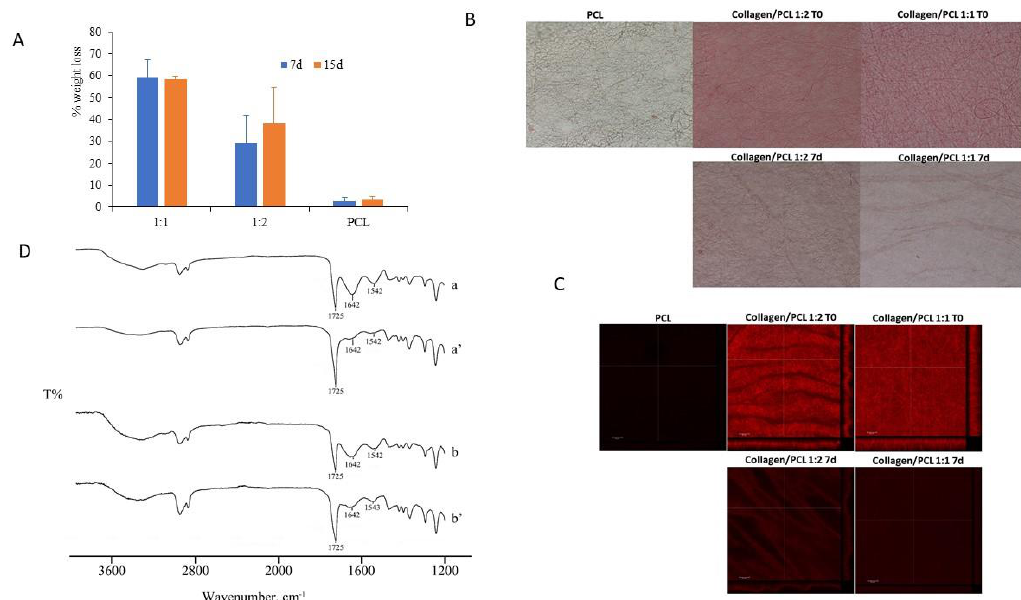
Figure 11. Collagen release from the nanofibrous membranes. ( A ) Weight loss (%) after 7 and 15 days in PBS. ( B ) collagen staining with eosin, optical microscope images, at time 0 and after 7 days in PBS. ( C ) collagen staining with eosin, CLSM images, at time 0 and after 7 days in PBS. ( D ) FTIR spectra at time 0 (a: collagen / PCL 1:1, b: collagen / PCL 1:2) and after 7 days in PBS (a’: collagen / PCL 1:1, b’: collagen / PCL 1:2).